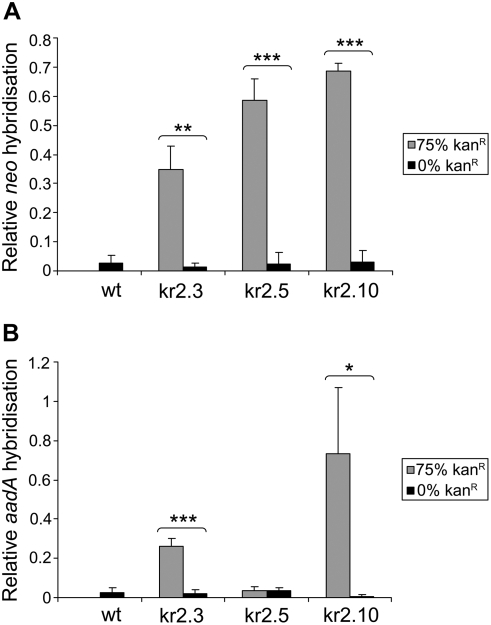
Quantification of DNA blot analysis.DNA slot blotting was performed using pooled DNA from at least 20 plants grown from seeds of a normally segregating self-fertilised seed capsule (75% kanR) and pooled DNA from at least 20 plants grown from a capsule which showed no kanamycin resistant progeny (0% kanR) for each of kr2.3, kr2.5 and kr2.10 (see Figure 1), as well as a wildtype control. Triplicates of each sample were probed with neo or aadA probes, followed by probing with ribosomal DNA as a loading control. The graphs show average hybridisation to neo (A) or aadA (B) after normalisation to ribosomal DNA hybridisation. Error bars show standard deviation. * P<0.05 ** P<0.01, *** P<0.001; Student's t-test.